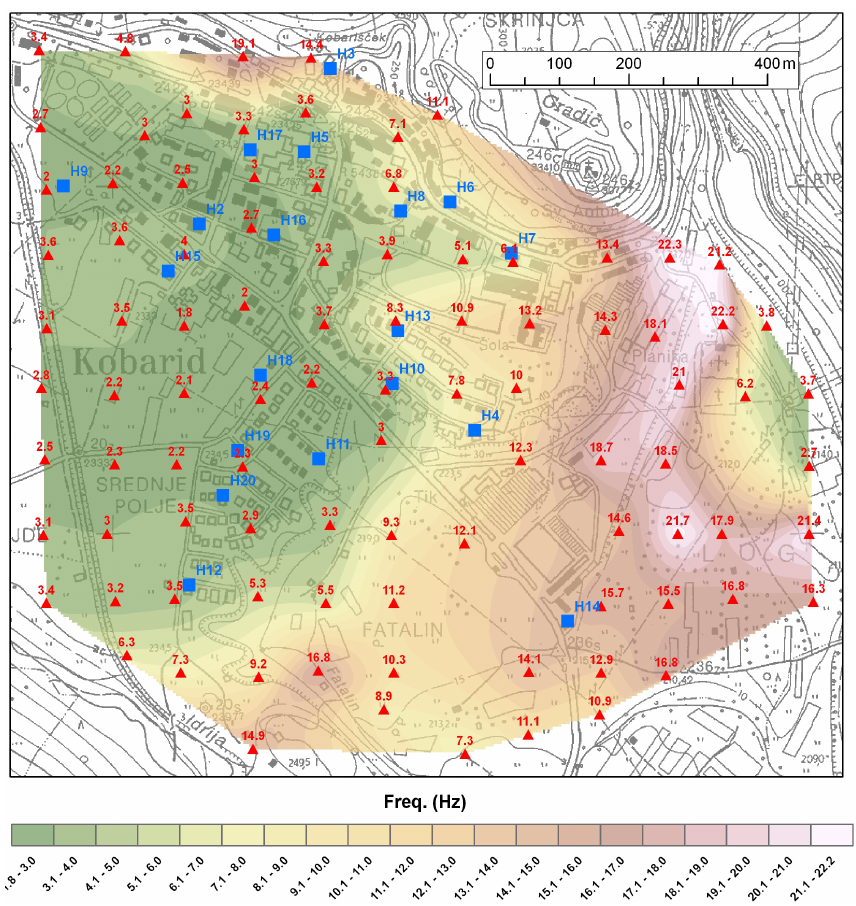
Fig. 6. Map of sediments resonance frequency derived from free-field microtremor data. Red labels indicate resonance frequency. Blue squares indicate location of buildings which were examined with microtremor